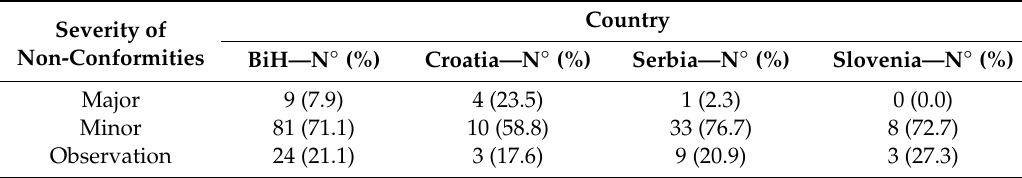
Table 7. The number and distribution of non-conformities by severity and countries.